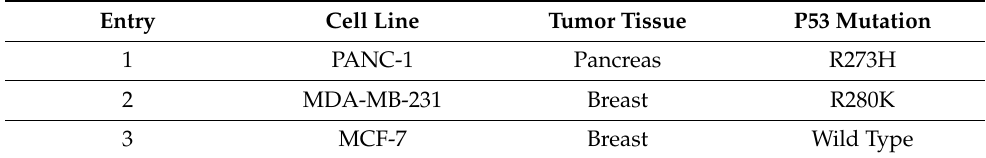
Table 3. p53 status of cell lines used in this